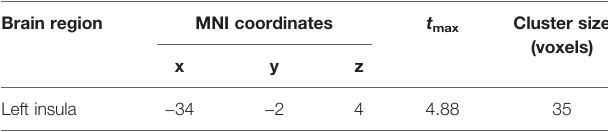
TABLE 5 | Functional magnetic resonance imaging (fMRI) result of whole-brain multiple regression analysis. The composite aggression value was positively correlated with the left